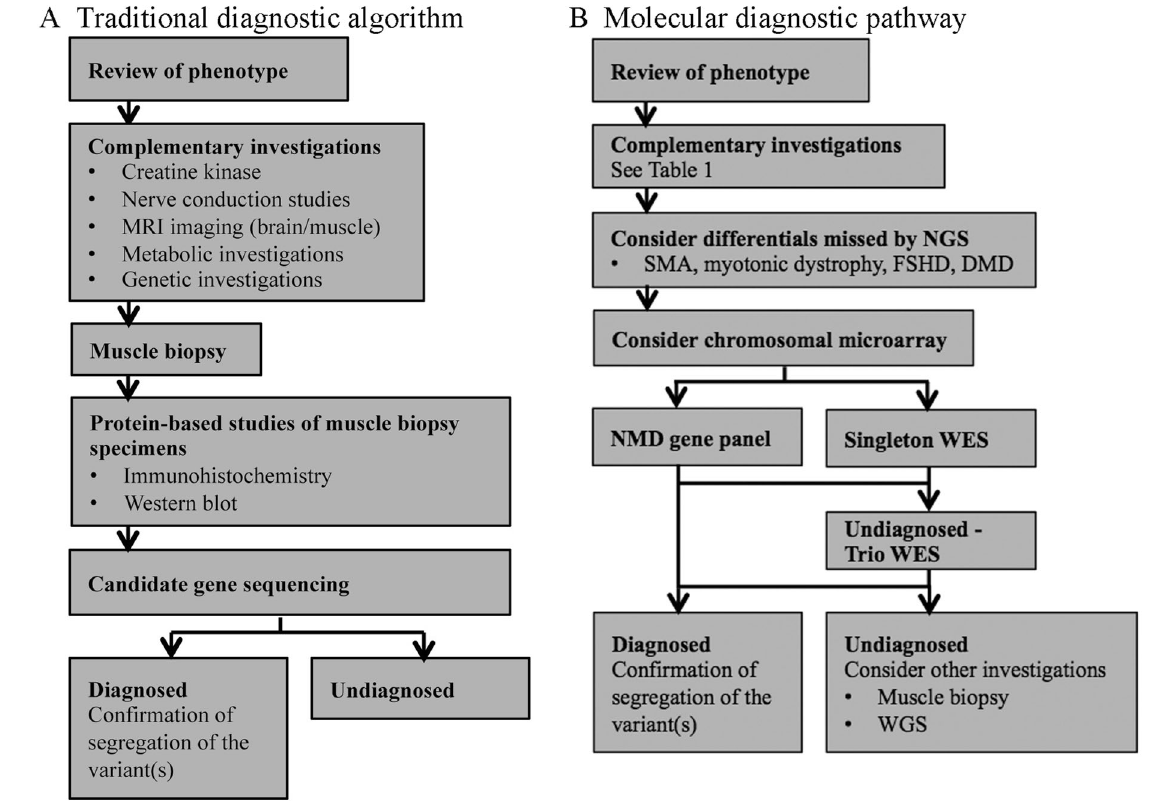
Fig. 1 Proposed diagnostic algorithms. a shows the traditional diagnostic algorithm based on muscle biopsy and protein-based studies of muscle biopsy specimens, followed by candidate gene sequencing. Complementary investigations were selected in the cohort by treating clinicians based on the presenting phenotype. b shows the proposed molecular approach to diagnosis. Complementary investigations were included dependent on the presenting phenotype, based on Table 2. Molecular investigation using either a NMD gene panel or WES was performed prior to muscle biopsy. NMD neuromuscular disease, WES whole exome sequencing, WGS whole genome sequencing, SMA spinal muscular atrophy, FSHD facioscapular humeral dystrophy, DMD Duchenne muscular